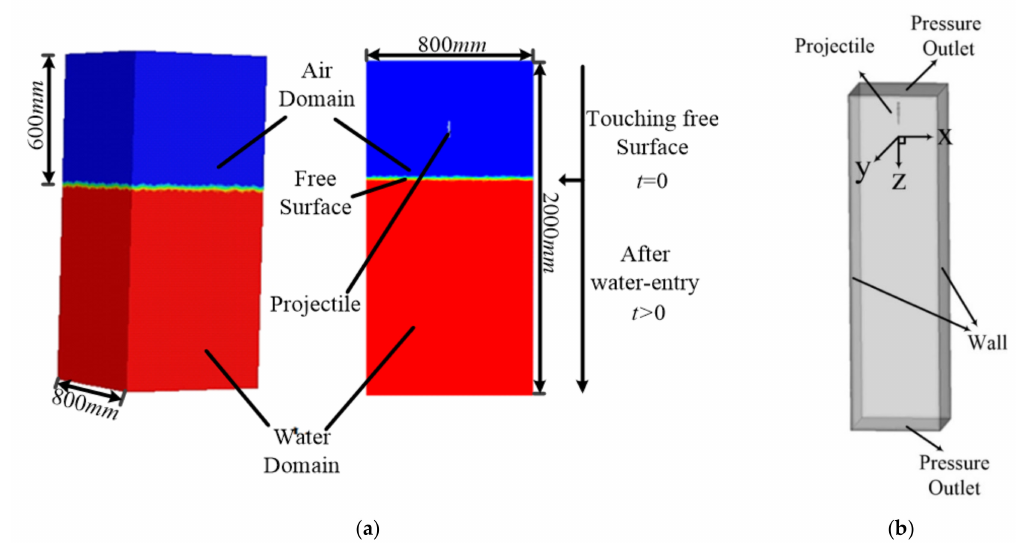
Figure 6. Computational domain and boundary conditions: ( a ) Computational domain; ( b ) Boundary